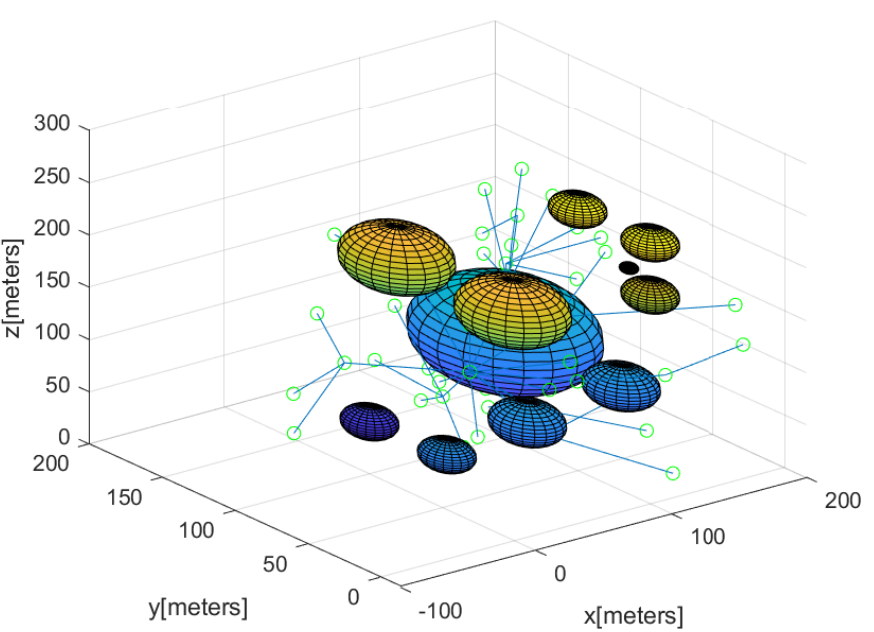
Figure 5. The initial position of every UUV is plotted with a green circle. We also plot the tree graph T (blue line segments) generated at time 0 (one MC simulation). We can see that the initial connectivity assumption is satisfied. Obstacles are plotted with